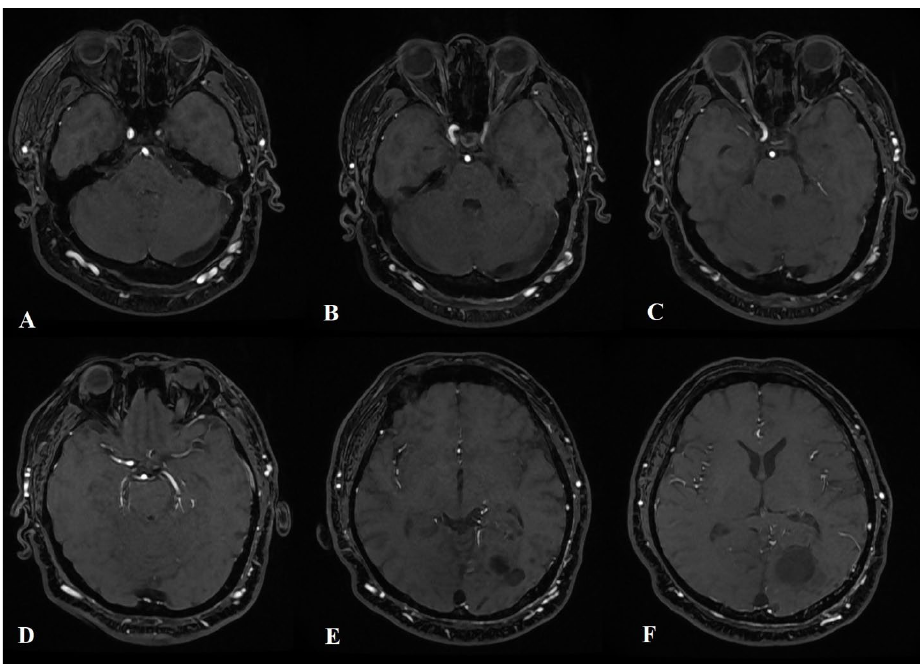
Figure 2. TOF MRA demonstrating the narrowing of the left ICA in the cavernous segment ( A , B ), its occlusion in the supraclinoid segment ( C ), and the reconstitution of flow in the distal branches ( D – F ).